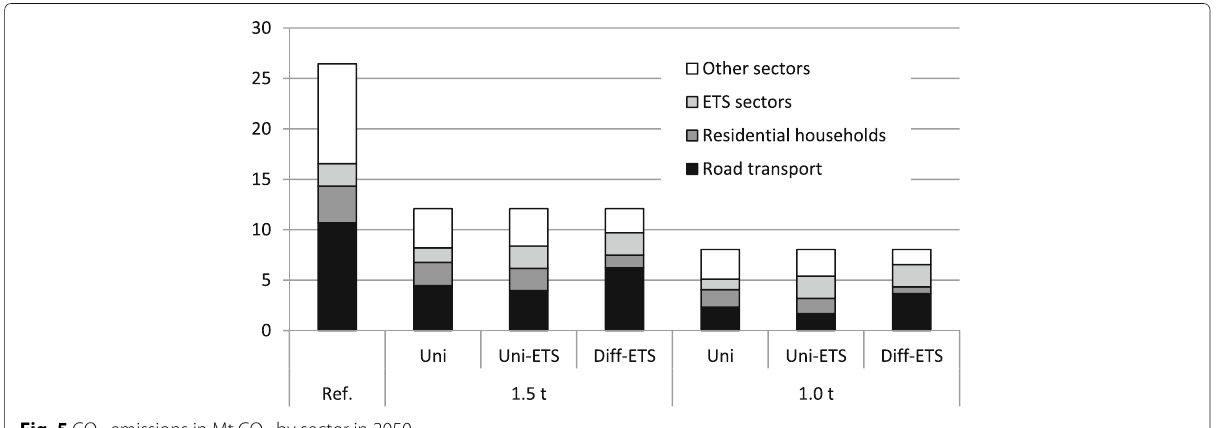
Fig. 5 CO 2 emissions in Mt CO 2 by sector in 2050